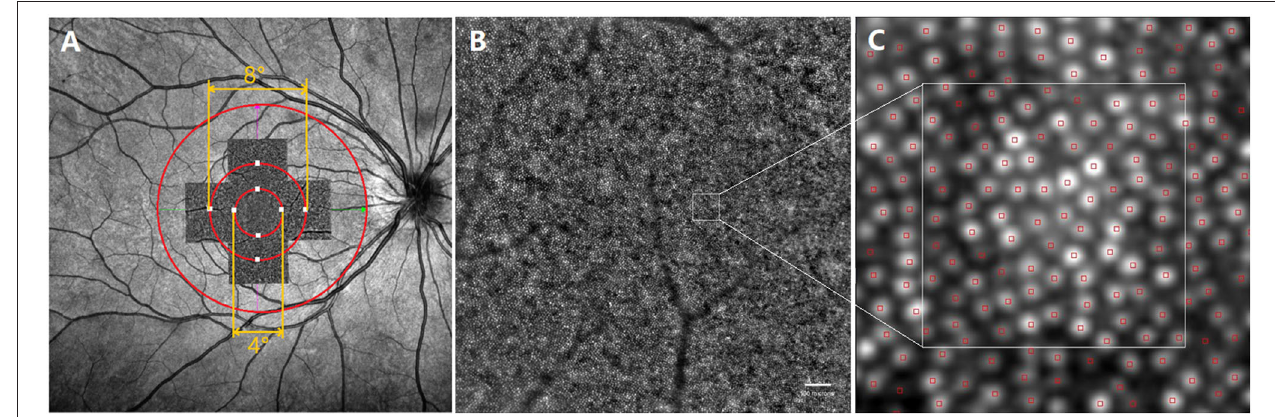
FIGURE 2 | Representative images of swept -optical coherence tomography angiography (SS-OCTA) and adaptive optics (AO). (A) The AO image is superimposed on the fundus image by SS-OCTA. The AO montage with a window size of 10 ◦ × 10 ◦ was created centered on the fovea. The eight white squares shown in the figure represent the measured locations, including four for the inner region (the circle with a diameter of 4 ◦ ) and four for the outer region (the circle with a diameter of 8 ◦ ); (B) one of the images that made up the AO montage. ROI, white square, represented acquisition window (the size of 100 × 100 µ m); (C) The white square is a magnified view of an ROI. SS-OCTA, swept-optical coherence tomography angiography; AO, adaptive optics; ROI, region of